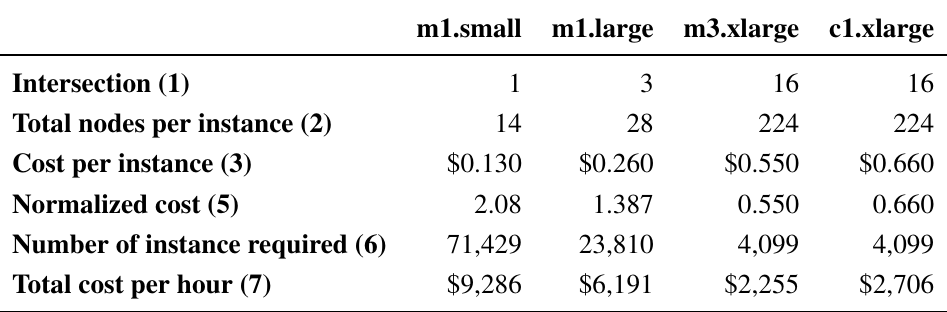
Table 2. Details on the cost and number of instances required to simulate an ITSnetwork with one million nodes based on the road surface network (RSN)